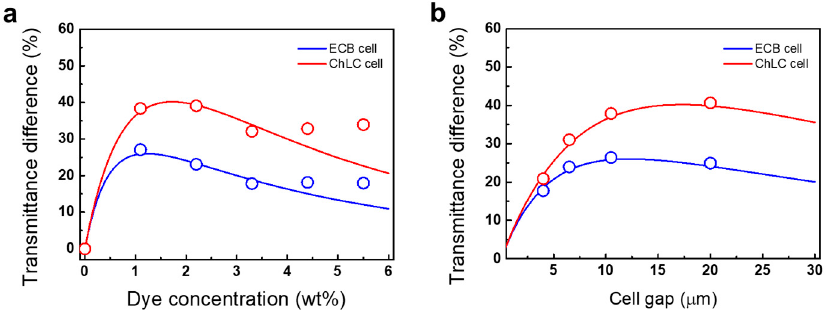
Figure 4. The calculated (solid line) and measured (empty circle) transmittance differences of ECB and ChLC cells as functions of the ( a ) dye concentration and ( b ) cell gap.